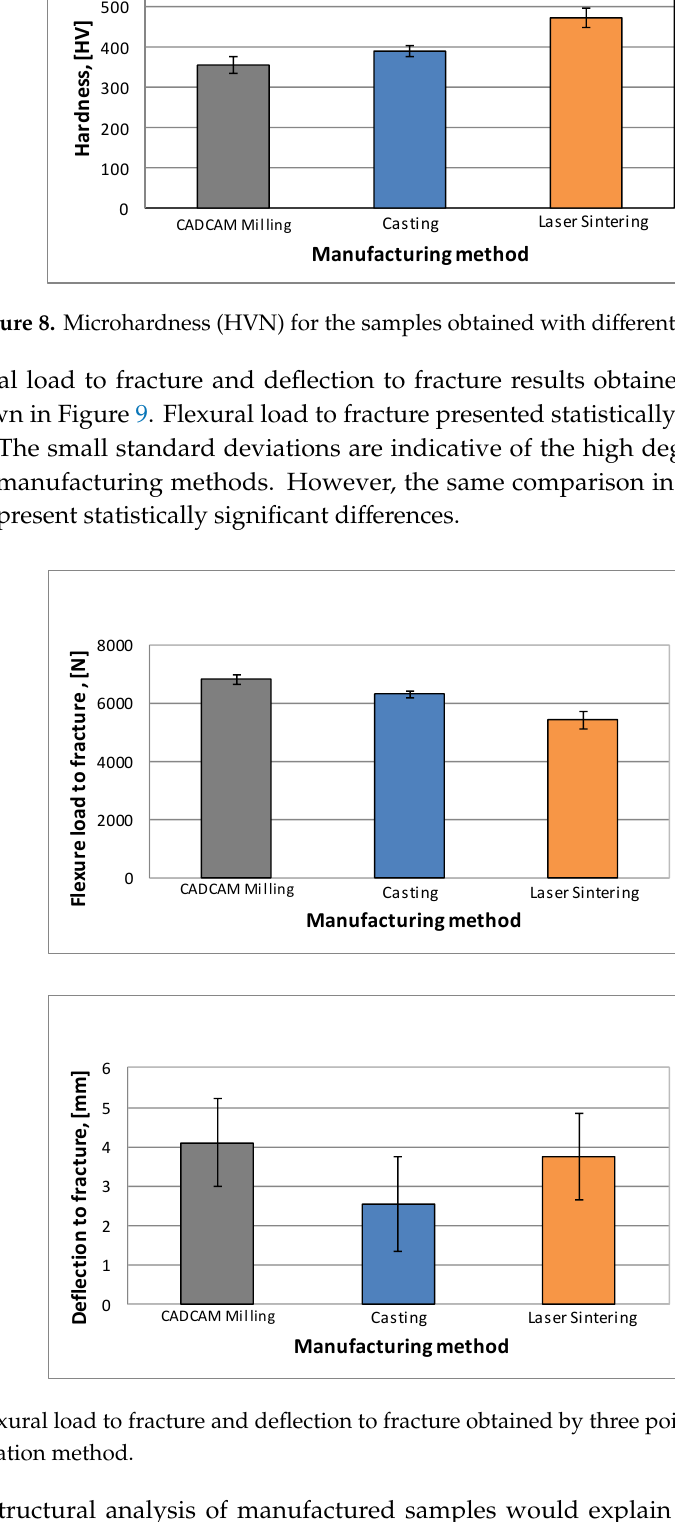
Figure 7. 3D topographic maps of three different models obtained by the White Light Interferometry (WLI) method: a ) Casting, b ) CADCAM, and c ) Laser sintering.